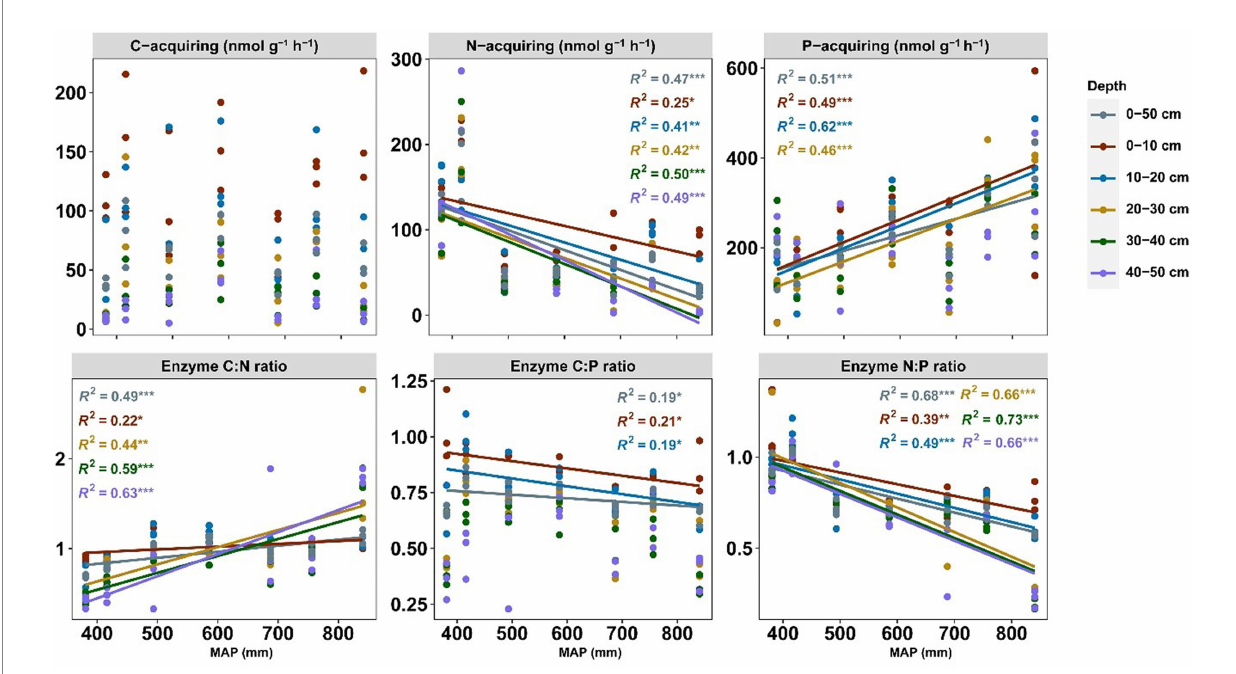
FIGURE 2 Patterns of enzyme activity and stoichiometry along the precipitation gradient for each soil layer. Colored lines represent the regression of each soil layer ( n = 105). Statistics ( R 2 and p values) for the regression are indicated using the corresponding colored text: *** p < 0.001, ** p < 0.01, and * p < 0.05. Only significant differences are shown. C, N, and P represent carbon, nitrogen, and